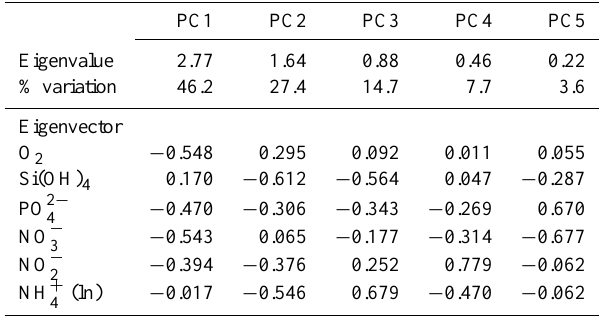
Table 3. Correlation-based principal component analysis (PCA) of normalised benthic boundary fluxes determined in the southeastern Beaufort Sea in July/August 2009. Eigenvalues and % of variation explained by the first 5 ordination axes (PC1, PC2, PC3, PC4, and PC5) is given. Linear coefficients (eigenvector) of each PC are given for each